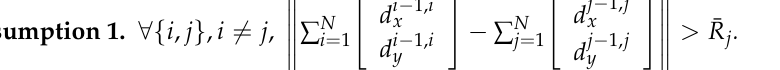
Figure 2. Leader–follower motion task executed by the formation of three